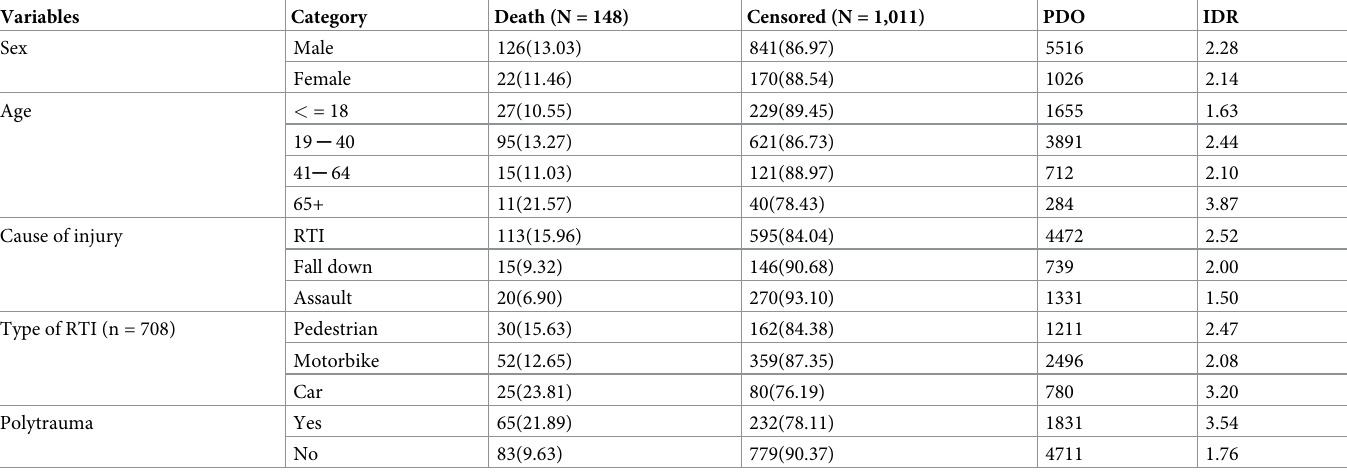
Table 1. Baseline demographic and injury-related characteristic head injury patients admitted to HUCSH from July 2017- July 2019, Hawassa, Southern Ethiopia. Variables